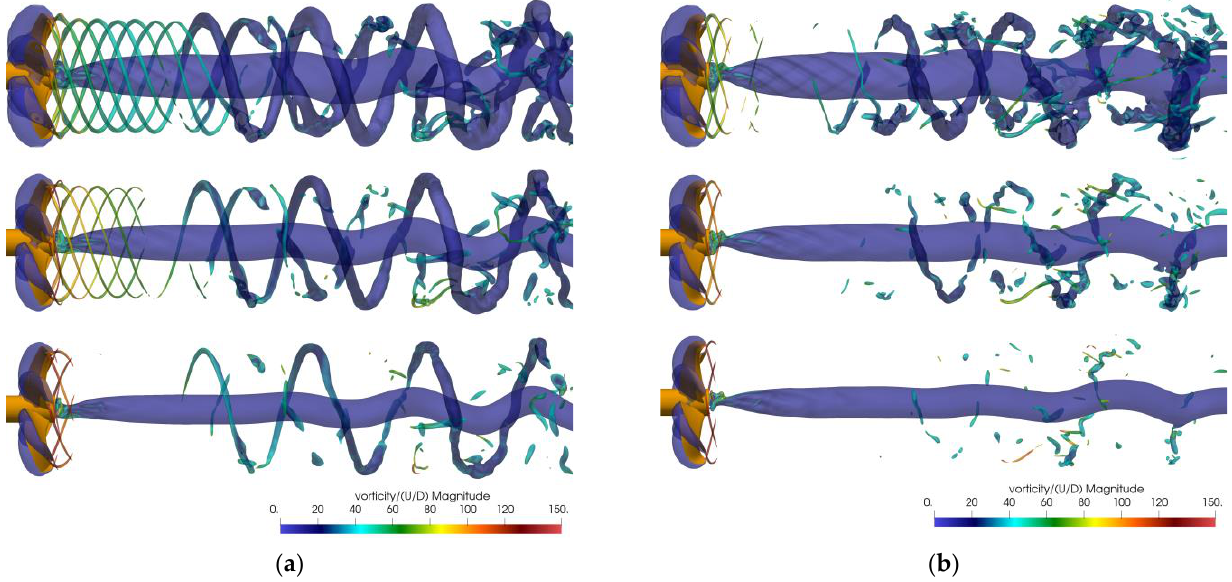
Figure 7. Instantaneous (22nd propeller revolution) isosurface of the pressure coefficient ( − C PN ) colored with the magnitude of vorticity scaled by U inf /D . From top to bottom: − C PN = 0.2, 0.3 and 0.4. Advance coefficient J equal to 0.6. Conventional CLT propeller on the left. ( a ) Conventional CLT; ( b ) New generation